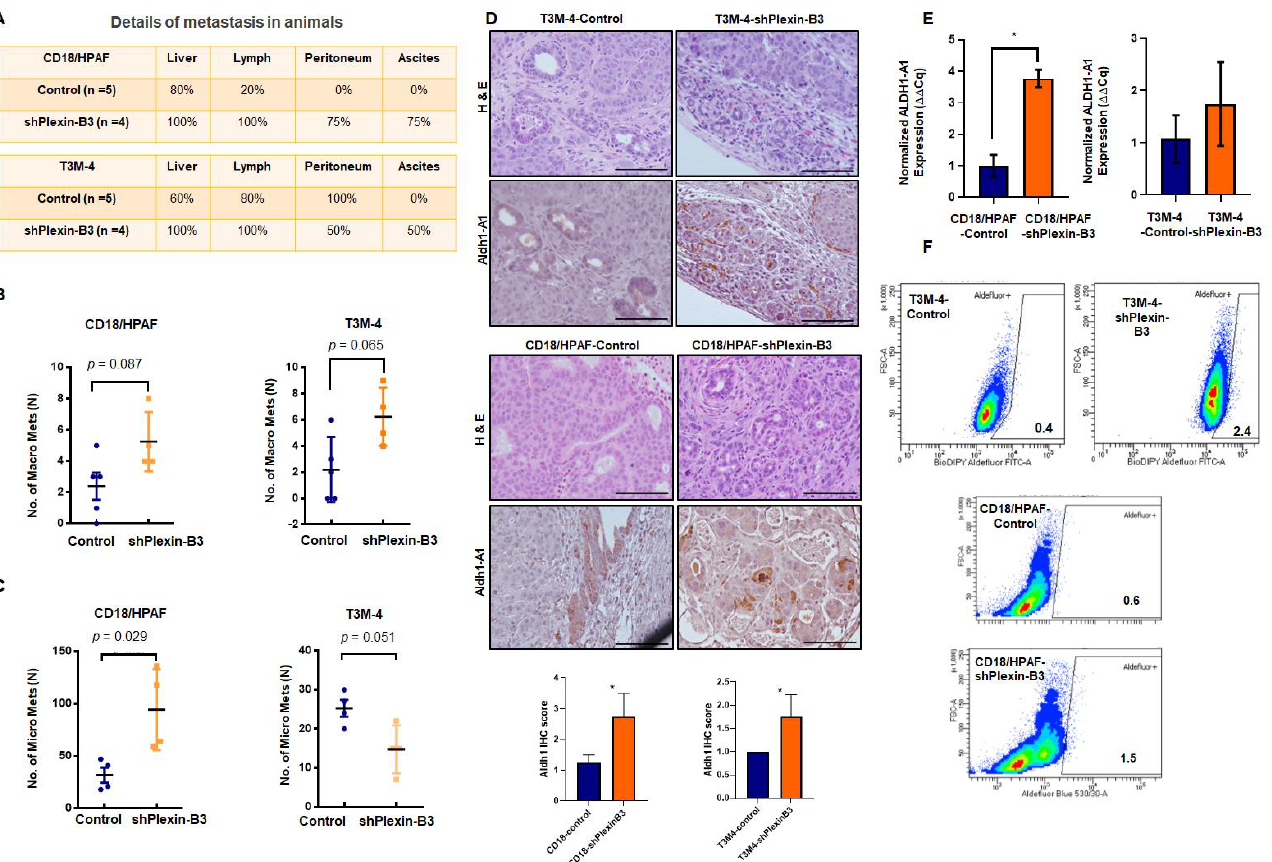
Figure 5. Loss of Plexin-B3 in PC cells enhances metastasis and induces stem cell-like characteristics compared to the control cells. ( A ) Chart of the percentage of metastasis incidence at different sites, like the liver, lymph node, peritoneum, and percentage of ascites formation in mice injected with CD18/HPAF- or T3M4- control and CD18/HPAF- or T3M-4-shPlexin-B3 cells. The chart shows a higher metastases and ascites incidence in mice injected with Plexin-B3 knockdown cells compared to the mice injected with control cells. ( B , C ) Graph showing the number of macro- ( B ) and micrometastases ( C ) in CD18/HPAF- or T3M-4-Control and CD18/HPAF- or T3M-4-shPlexin-B3 groups and the average number of metastases. ( B ) The graphs show a higher number of macrometastases formations in a group of mice injected with CD18/HPAF-shPlexin-B3 ( p = 0.089) or T3M-4-shPlexin-B3 cells ( p = 0.065) in comparison with the group injected with their respective control cells. ( C ) The graphs show a higher number of micrometastases formations in a group of mice injected with CD18/HPAF-shPlexin-B3 ( p = 0.029) or T3M-4-shPlexin-B3 cells ( p = 0.051) in comparison with the group injected with their respective control cells. The values in the graphs represent the number of macrometastases or micrometastases in the liver per mouse. The error bars in the graphs represent the SEM. The statistical p -value was calculated using a nonparametric Mann–Whitney U Test. ( D ) Representative images of ALDH1-A1 IHC and H&E staining of the primary tumor burden formed by the CD18/HPAF-shPlexin-B3 or -Control cells and T3M-4 -shPlexin-B3 or T3M-4 control cells showing higher ALDH1-A1-positive cells in the shPlexin-B3 group in comparison with their control cells group. The scale bar represents 100 µ m. (* p ≤ 0.05) ( E ) Bar graph showing the relative fold increase in mRNA expression of ALDH1-A1 in CD18/HPAF- and T3M4-shPlexin-B3 samples compared with their respective controls. HPRT is used as a control. The values are the mean relative fold changes ± SEM, bars. (* p ≤ 0.05) ( F ) Flow cytometry shows a higher ALDH1 expression using the ALDH1 enzymatic assay in T3M-4-shPlexin-B3 cells in vitro compared to T3M-4-Control cells. Diethylaminobenzaldehyde (DEAB), an inhibitor of ALDEFLUOR, was used as a negative control for each cell